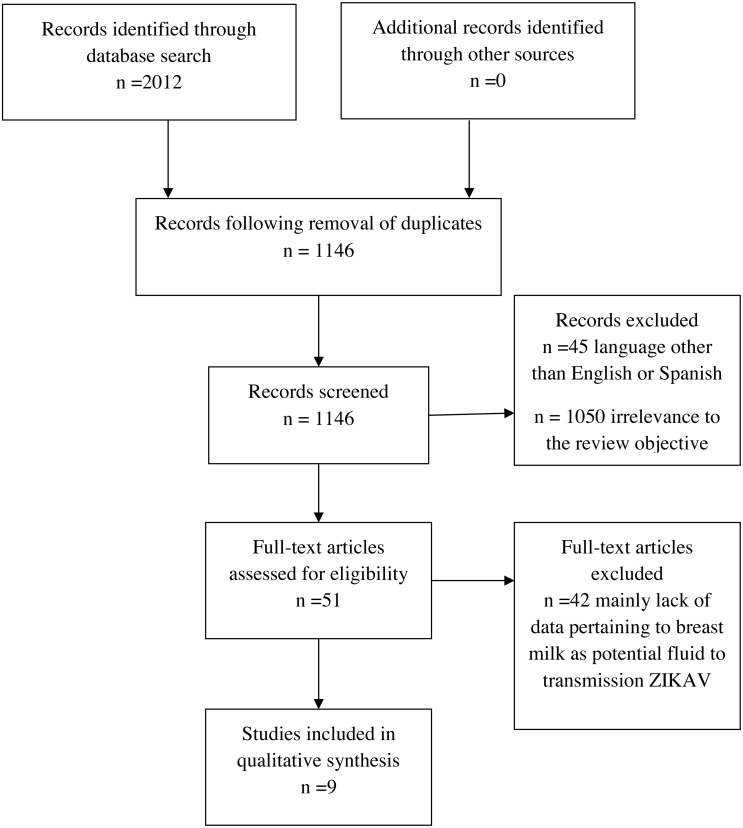
Systematic review process.